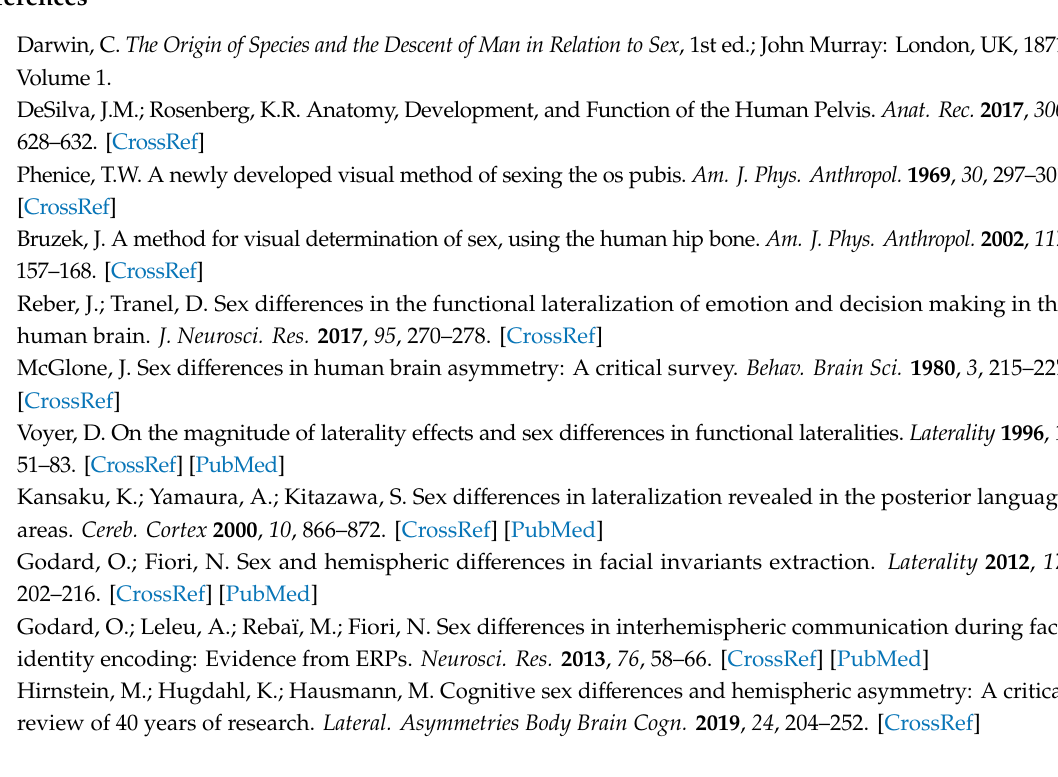
expression A or B: gene expression mean value of all data available for a locus; expression A / B: gene expression ratio of value A / value B; SD: standard deviation of the expression value indicated as percentage of the mean; Table S2: Map mode analysis at single gene level of pool A (hADSCs from male subjects) vs. pool B (hADSCs from female subjects). The 8909 resulting loci are sorted in descending order of expression ratio (A / B). Gene name: o ffi cial gene symbol as indicated in gene database (the genes in bold are the over- or underexpressed in a statistical manner); Chr: chromosome; location: segment cytoband; segment start / end: chromosomal coordinates for each segment; expression A / B: gene expression ratio as mean value of all data available for a locus in pool A on pool B; q: p -value corrected for FDR (false discovery rate) of the segment; Table S3: ShinyGo enrichment analysis of genes di ff erentially expressed in hASC male vs female. Gene ontology (GO) functional analysis of di ff erentially expressed genes resulted from TRAM analysis at a single gene level. The GO enrichment analysis is based on Biologic Process functional categories of the ShinyGo v0.61 software. The results, ranked by FDR (false discovery rate) in the table, were obtained with a p -value cuto ff (FDR) = 0.05 and 20 as number of most significant terms to show; Table S4: List of 19,287 TRAM mapped loci for which an expression value C / D was calculated (hADSC female + FGF vs. hADSC female -FGF). Loci are sorted in descending order. Gene name: o ffi cial gene symbol as indicated in gene database; Chr: chromosome; data points: number of spots associated with an expression value for the locus; expression C or D: gene expression mean value of all data available for a locus; expression C / D: gene expression ratio of value C / value D; SD: standard deviation of the expression value indicated as percentage of the mean; Table S5: Map mode analysis at single gene level of pool C (hADSC female + FGF) vs. pool D (hADSC female -FGF). The 8353 resulting loci are sorted in descending order of expression ratio (C / D). Gene name: o ffi cial gene symbol as indicated in gene database (the genes in bold are the over- or underexpressed in a statistical manner); Chr: chromosome; location: segment cytoband; segment start / end: chromosomal coordinates for each segment; expression C / D: gene expression ratio as mean value of all data available for a locus in pool C on pool D; q: p -value corrected for FDR (false discovery rate) of the